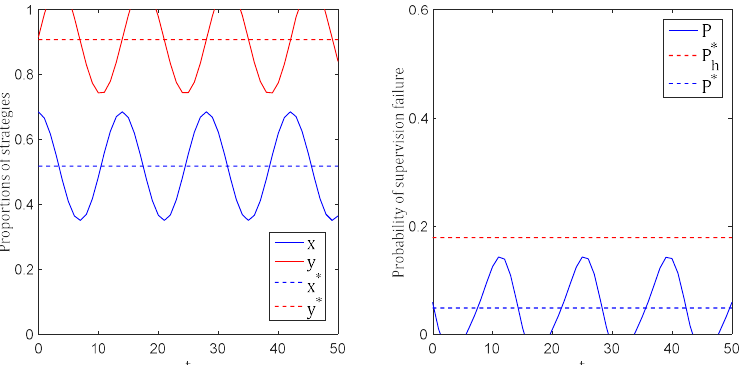
Figure 1. Periodical fluctuation in proportions of strategies ( left panel ) and probability of supervision failure ( right panel ) in initial state ( x 0 , y 0 ) = ( 0.35,0.9 ) .